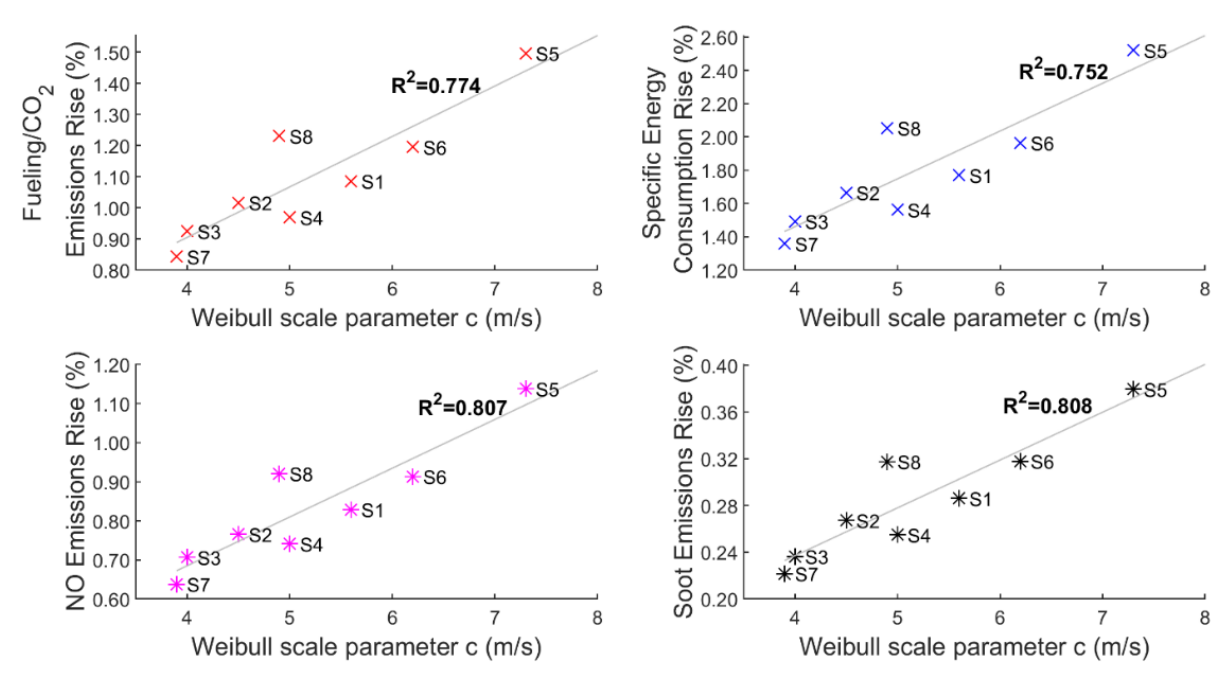
Figure 5. Expected rise in fuel/energy consumption and emissions vs. Weibull scale parameter